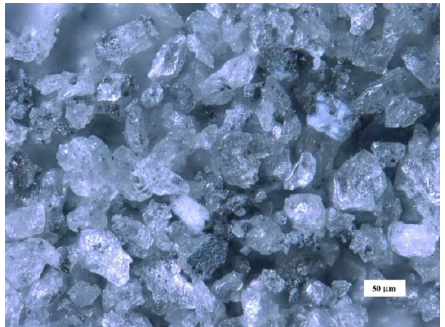
Figure 8. Optical microscopy image of the deposit obtained on the GC electrode from the equimolar AlCl 3 -NaCl melt containing anodically dissolved Ti at − 0.020 V and 300 °C for two hours. Data acquired from the XRD analysis of the deposits are shown in Figure 9.